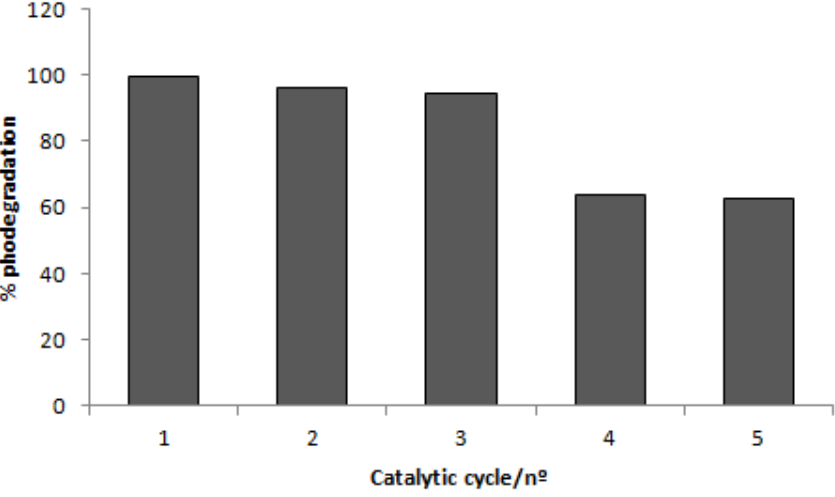
as a function of its reuse of 30 mg·L − 1 2